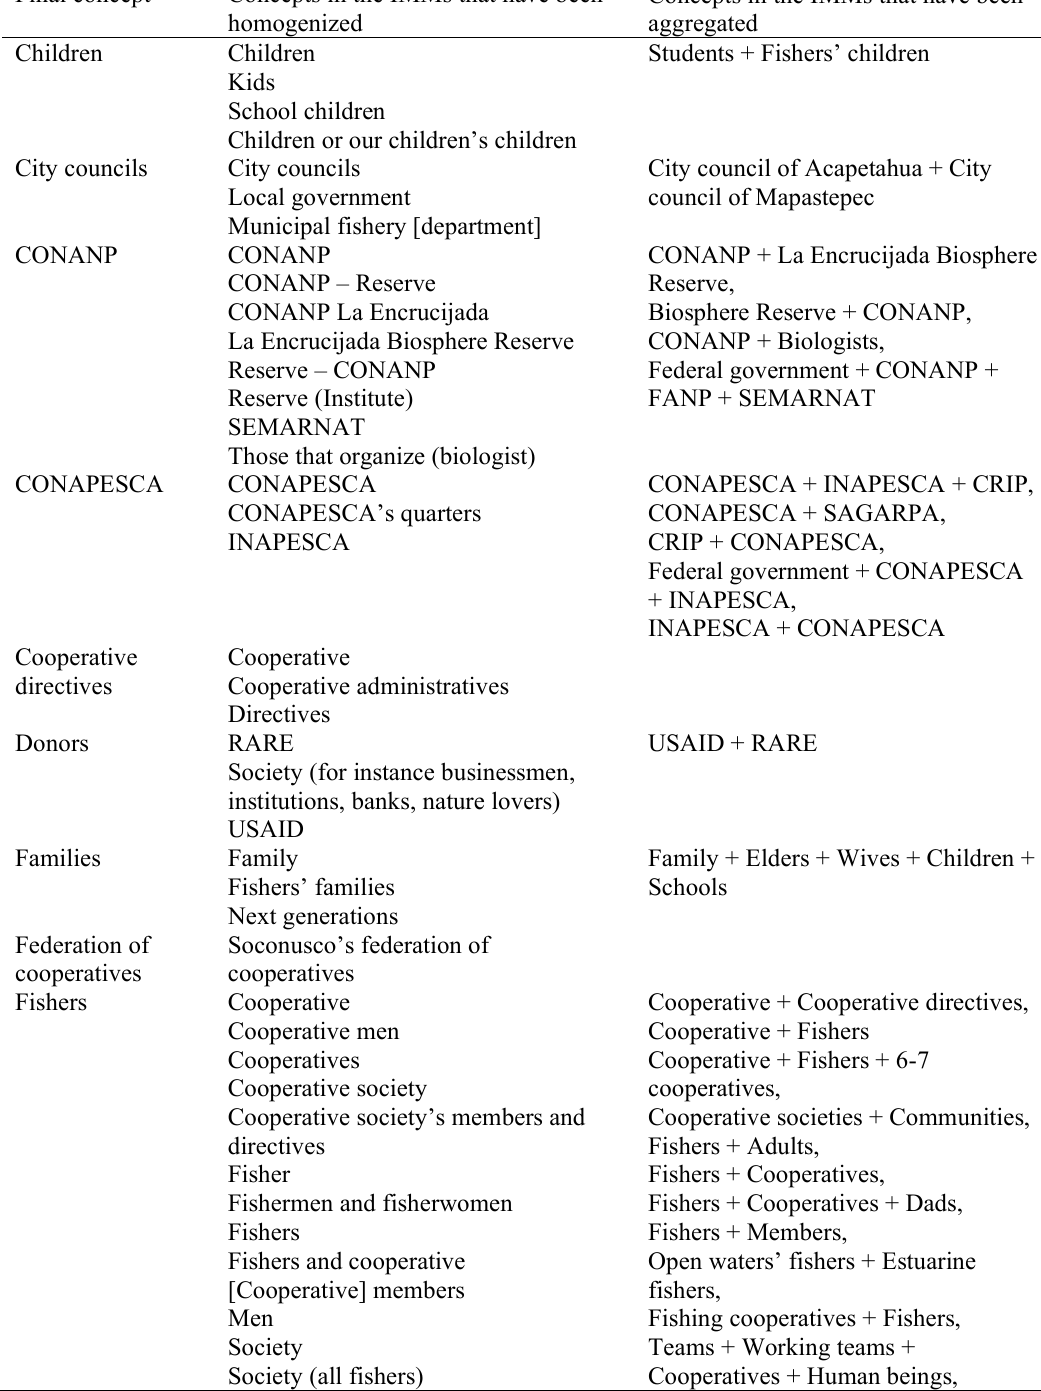
Table A2.1. Qualitative aggregation of